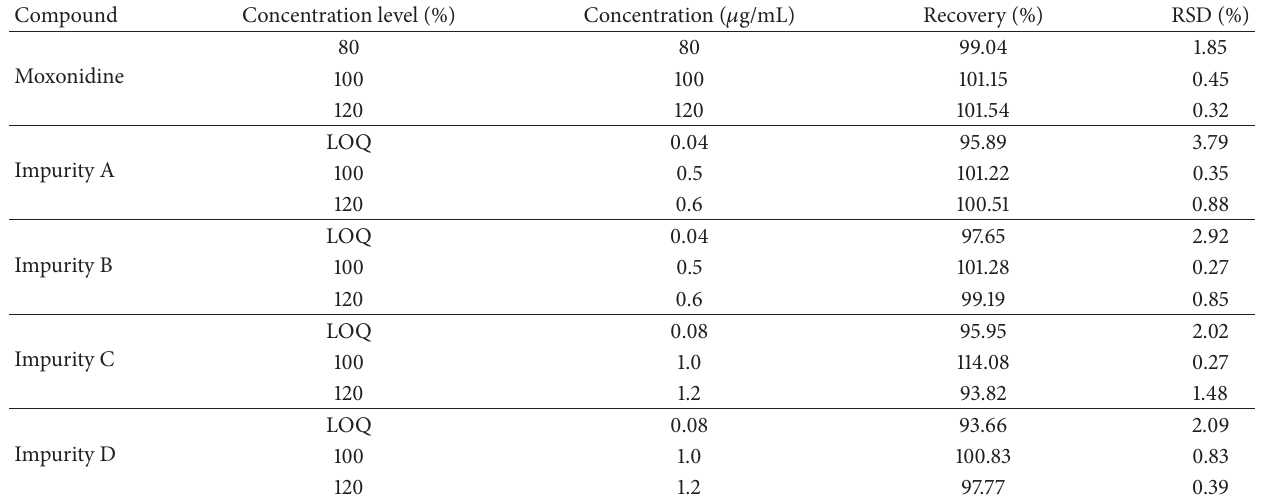
Table 4: Accuracy and precision of the